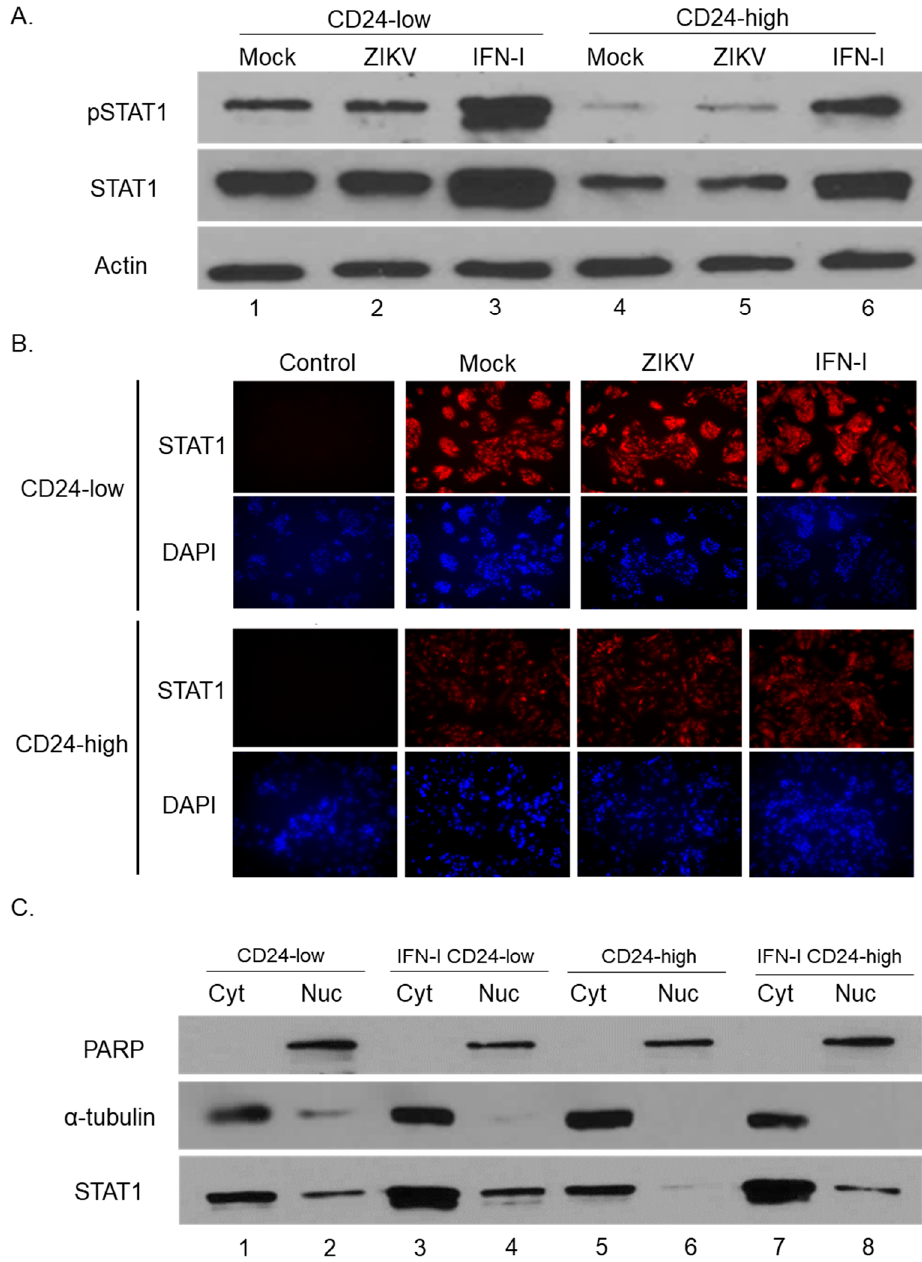
Figure 2. CD24-low and CD24-high cells differ in total levels, phosphorylation, and cellular distribu- tion of STAT1. ( A , B ) Cultures of CD24-low and -high cells were either mock-infected, ZIKV-infected at MOI 5, or treated with 10 u/mL of IFN-I for 18 h. Levels of STAT1, pSTAT1, and actin proteins were analyzed by Western blotting ( A ). Alternatively, STAT1 levels were also determined by immunostaining ( B ) with an antibody to STAT1 (red) and nuclear DAPI (blue). Exposure times for immunofluorescence and DAPI were the same between mock- and ZIKV-infected CD24-low and CD24-high cells. Images are shown at 20× magnification. ( C ) CD24-low and -high cells were either left untreated or treated with 10 units/mL of IFN-I for 18 h. Cell lysates were fractionated into cyto- plasmic (Cyt) and nuclear (Nuc) fractions before analysis by Western blotting for PARP as a nuclear marker, α -tubulin for a cytoplasmic marker, and total STAT1.